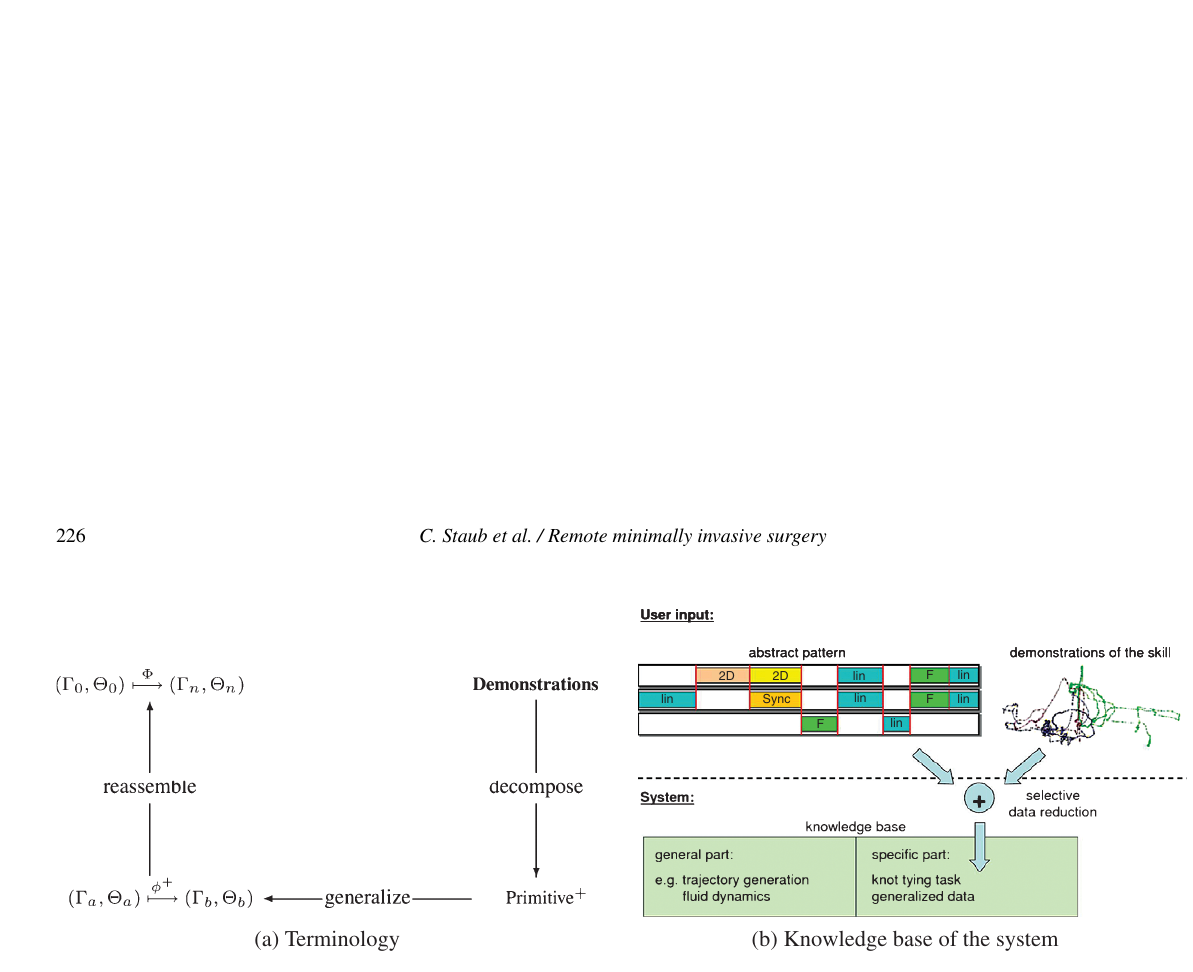
primitive and “Sync” for a synchronized motion. The vertical red lines denote synchronization points. After all, it is possible to construct a broad variety of different tasks out of only four tasklets as they are defined